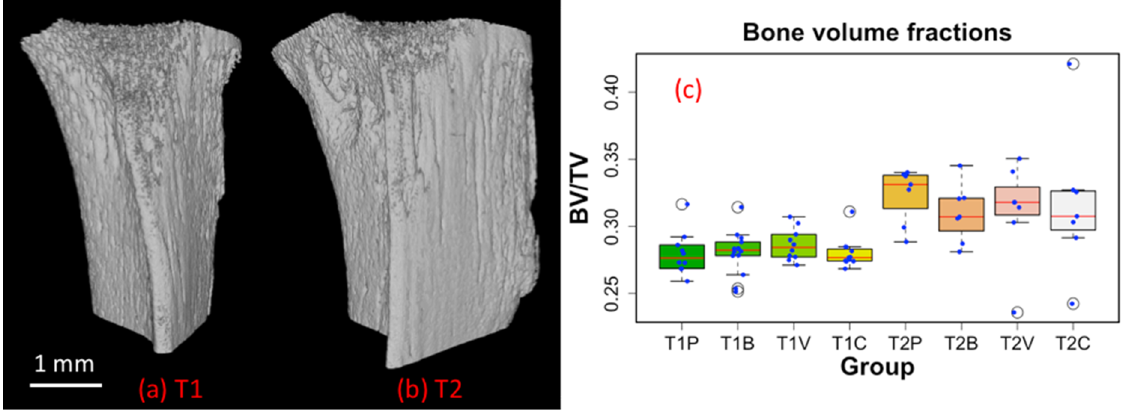
Figure 4. ( a ) 3D rendering of the segmented bone at the first time point (T1). ( b ) Same as in ( a ) at the second time point (T2). ( c ) Measurement of bone volume fraction (BV/TV). All data points (blue) were plotted along with the box plots. T1 and T2 denote time points at day 8 and 22 post tumor cell inoculation, respectively (P: Placebo, B: Bevacizumab, V: Vatalanib, C: Combination of Bevacizumab and Vatalanib).